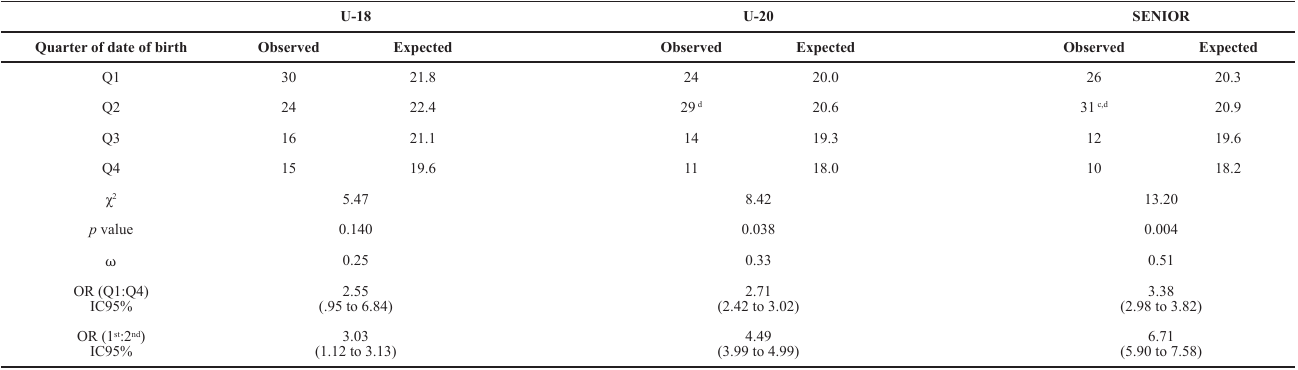
Table 2 - Absolute distribution of dates of birth as a function of the tournament category for female handball players.